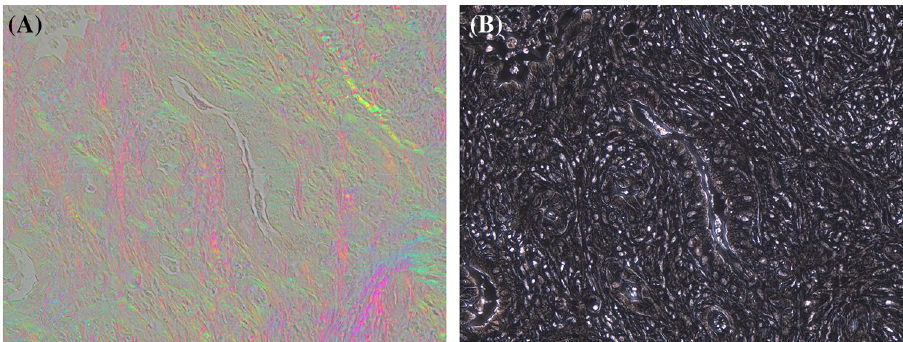
Figure 5. ( A ) Shows a pancreatic ductal adenocarcinoma surrounded by fibrotic tissue that has been visualized using PPM. ( B ) Shows the phase contrast imaging of the same region to demonstrate the cellular structures. The tissue area represented in images is 433 × 330 µm.